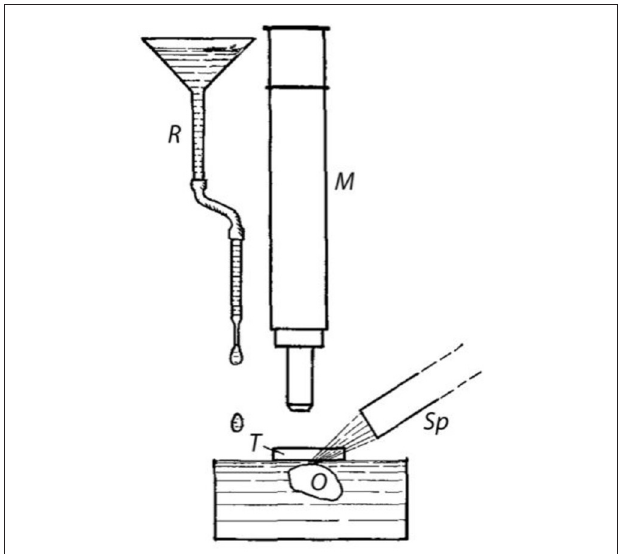
FIGURE 2 | Device for the generation of fluid flow. O = Object, i.e., preparation with opened ampulla; T = Slide as protection against image distortion (cf. text); M = microscope; Sp = slit lamp; R = reservoir and tube for applying drops onto the water surface.